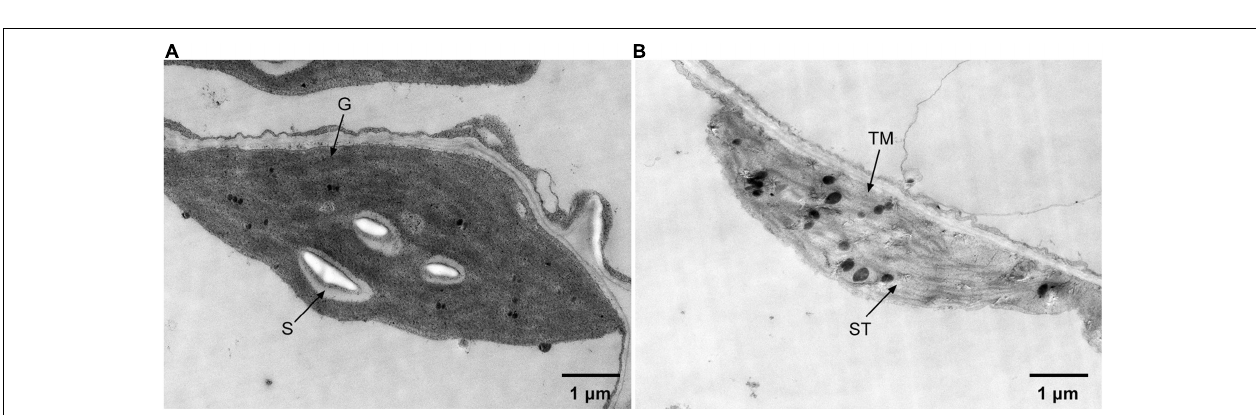
FIGURE 7 | Ultrastructure of chloroplasts in panel (A) . Control (B) . ZjPPH -overexpressing plants. ST, stroma; S. starch; G. grana stacks; TM, thylakoid membrane.